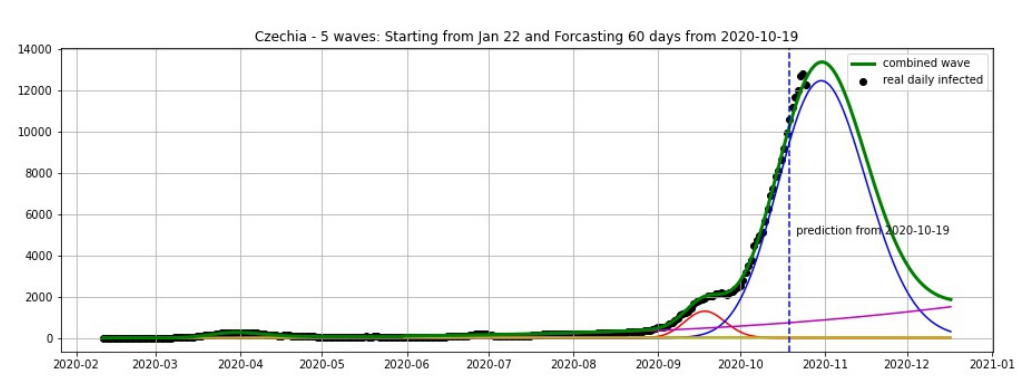
Figure 3. Czechia: fitting and forecasting (green curve) from 25 October with 5 wavelets. The green curve is the combination of other curves which are EF wavelets.